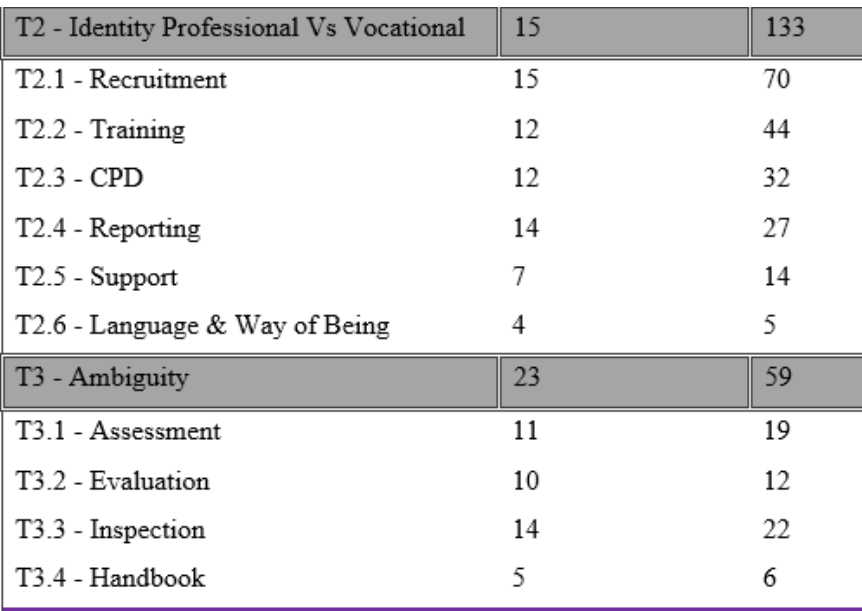
Figure 1. Development of themes using NVivo. Codebook snapshot of Phase 5—Defining and Naming Themes.